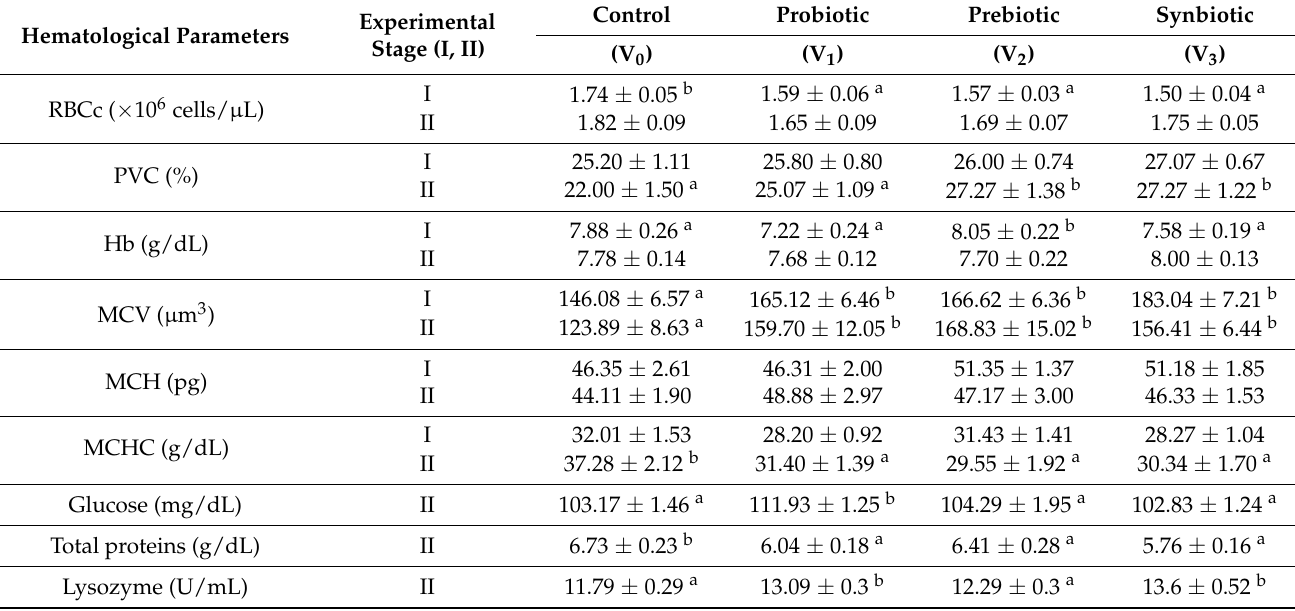
Table 2. Hematological and biochemical parameters of tilapia in two experimental stages.